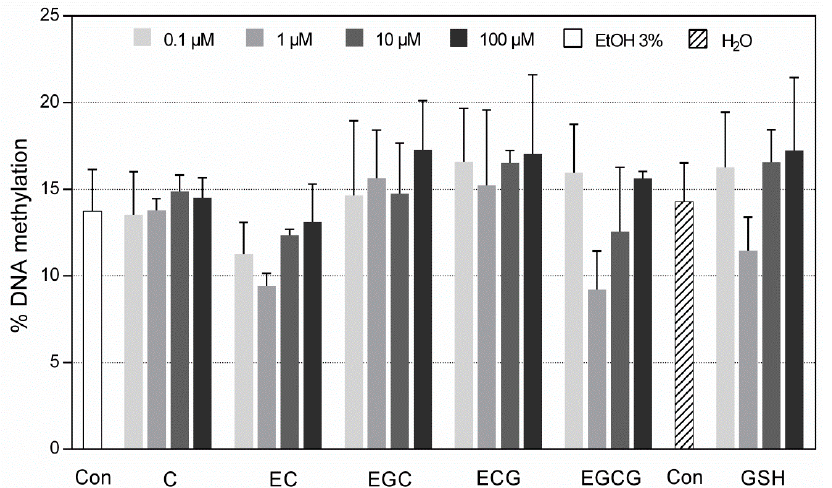
Figure 4. Changes in DNA methylation of specific CpGs induced in HT29 cells by catechins at 0.1–100 µM concentrations. Relative methylation level of the primer-binding sequence in the SRXN1 promoter region was investigated by methylation-specific PCR (MSP) with M1/U1 primer sets (M1/U1, methylated and unmethylated primer, respectively). The results are means ± SD of three biological replicates. No statistically signi fi cant changes were detected by one-way ANOVA with Dunne tt (cid:31)s test. Abbreviations: C, (+)-catechin; Con, control; EC, ( − )-epicatechin; EGC, ( − )-epigallocatechin; ECG, ( − )-epicatechin gallate; EGCG, ( − )-epigallocatechin gallate; GSH, glutathione.